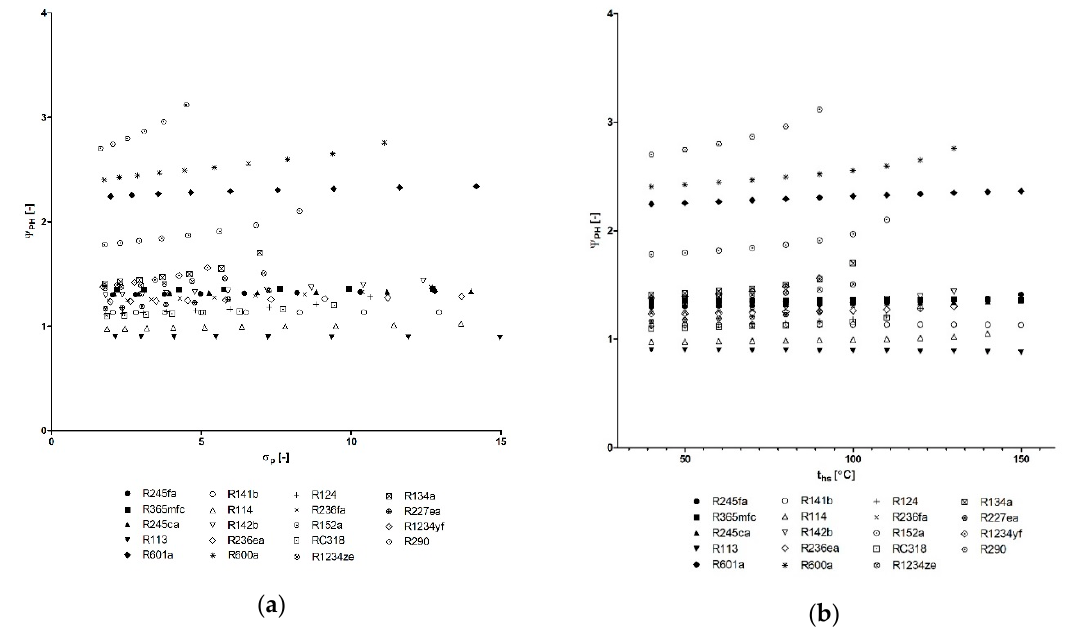
Figure 11. The variation of the ψ PH parameter vs. the pressure expansion ratio and heat source temperature: ( a ) ψ PH = f( σ P ); ( b ) ψ PH = f(t hs